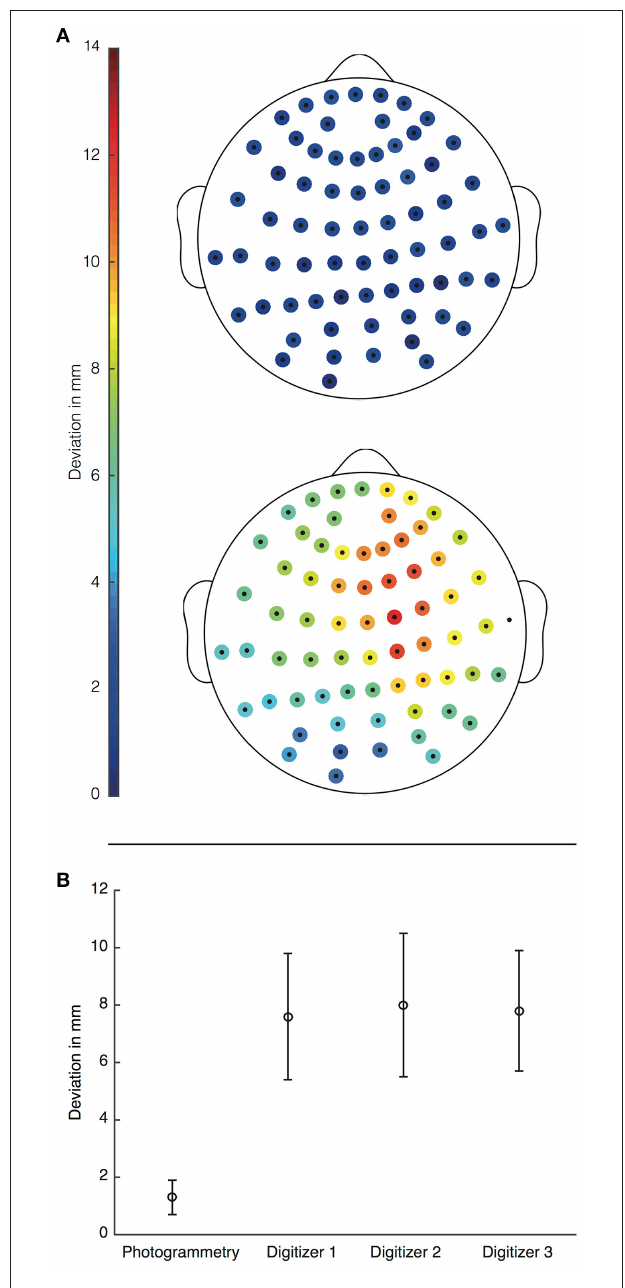
FIGURE 6 | (A) Topographies for deviations of all electrode coordinates in mm. Those determined with the photogrammetry-based approach (top) had a mean deviation of 1.3 mm whereas the deviation obtained from the electromagnetic digitizer (bottom) was 7.6 mm. (B) The average deviation (SD) for both methods was 1.3 mm (0.6 mm) for the photogrammetry ( A —top) and 7.6 mm (2.2 mm) ( A —bottom), 8.0 mm (2.5 mm) and 7.8 mm (2.1 mm) for the electromagnetic digitizer. Error bars indicate the respective standard